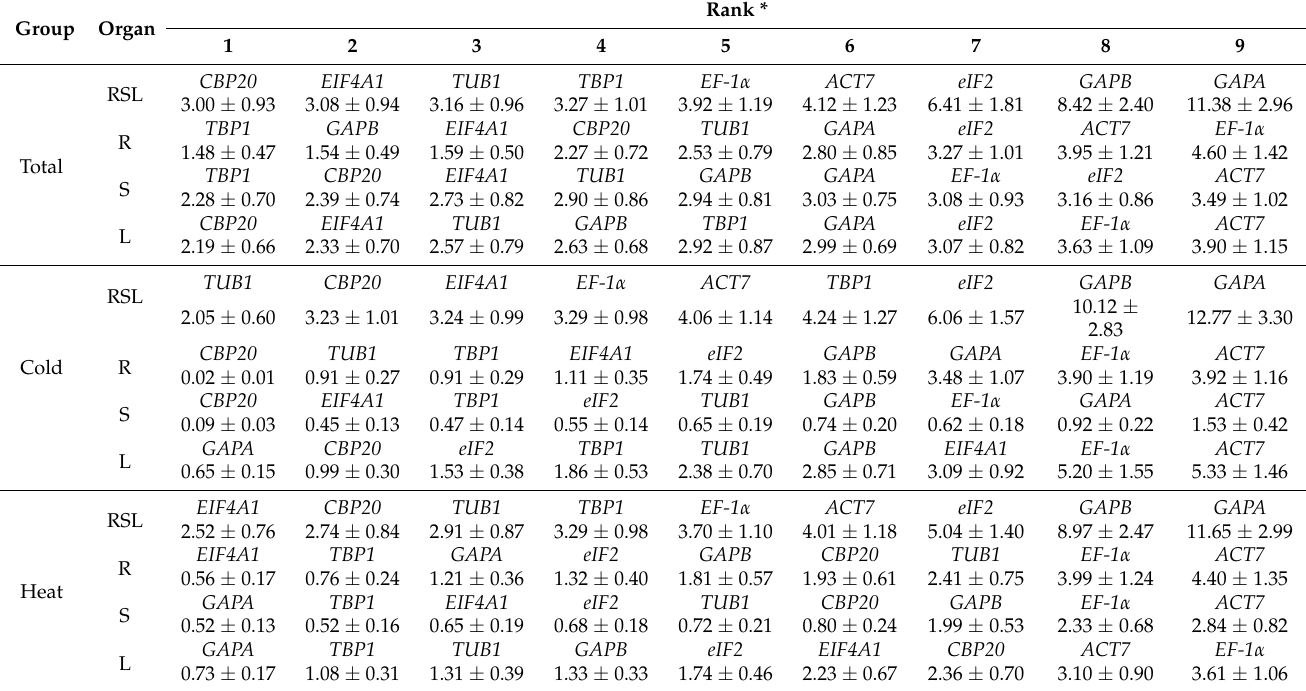
Table 2. Expression stability values for nine candidate reference genes calculated by